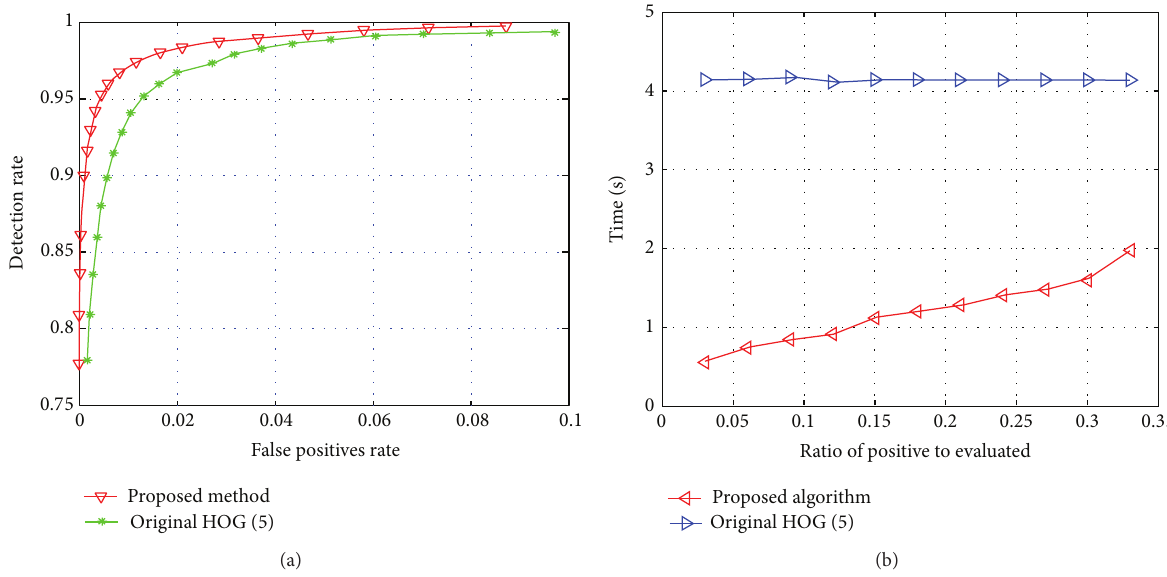
Figure 6: Comparison result when we tested our proposed method and original HOG by Dalal et al . (a) Comparison of detection rate and (b) comparison of time